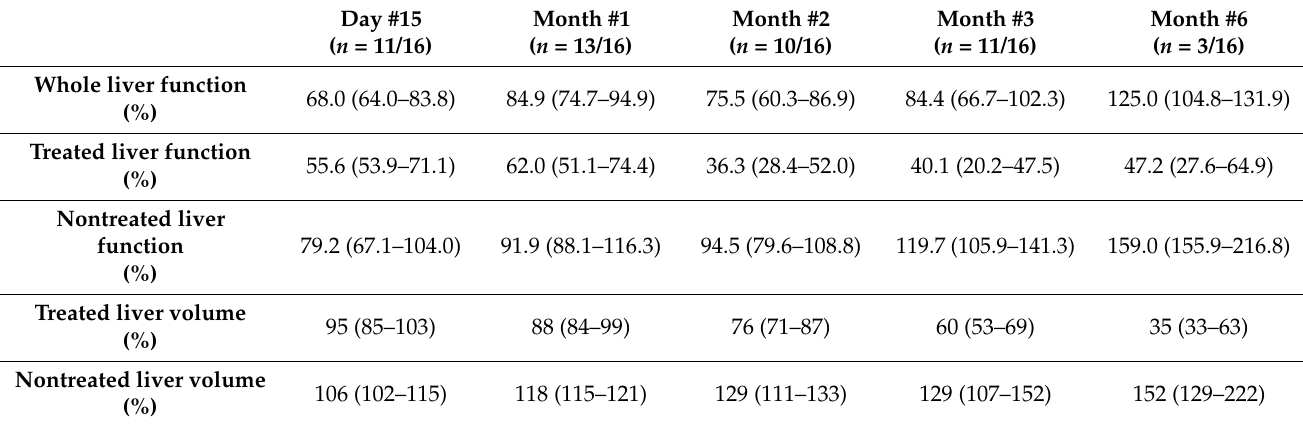
Table 2. Regional liver function and volume, relative to